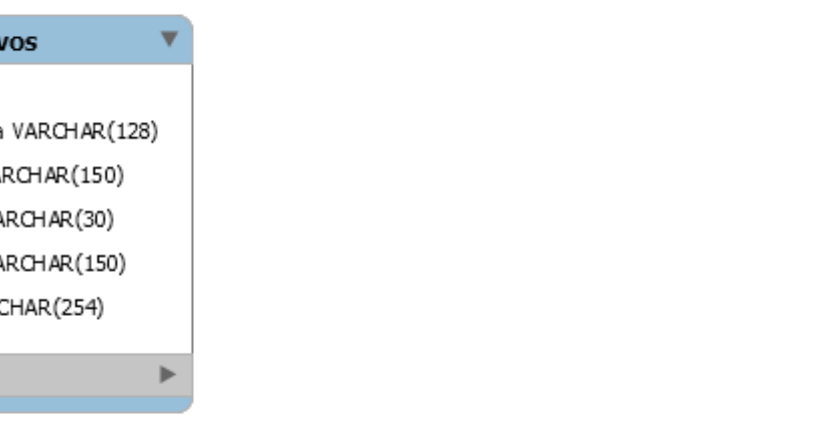
Figure 7. Web application database diagram. Since the mobile app web service and web app share the database, only one additional table was added for the web